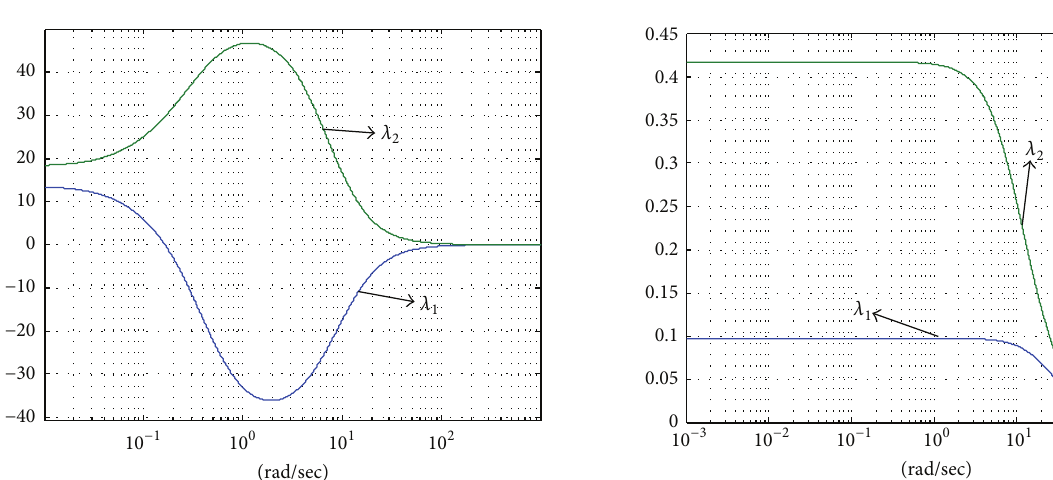
Figure 6: Eigenvalues of [𝐺 3 (𝑗𝜔) + 𝐺 ∗ 3 (𝑗𝜔)] (Case 3 ).